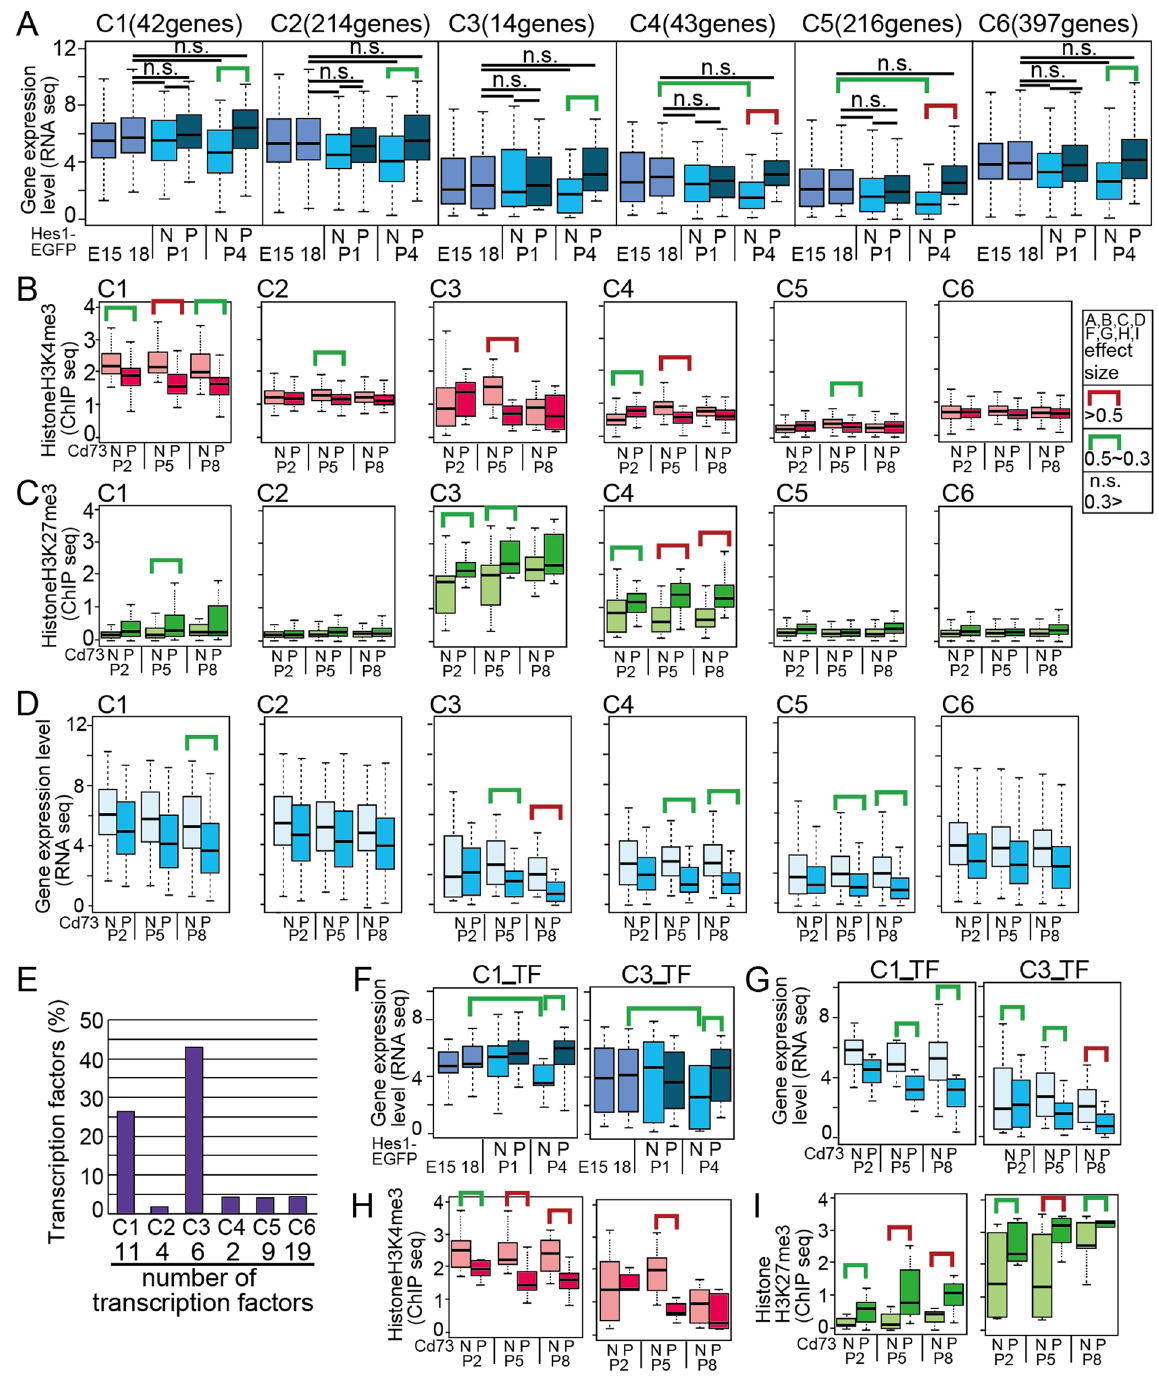
Figure 6. Characterization of genes upregulated in P4 but not in P1 in pHes- EGFP positive cell populations. Genes of pHes1-EPG at P4 but not included in pHes1-EPG at P1 were sub-clustered to C1 to C7 by using their values of H3K4me3 and H3K27me3 ChIP-seq of Cd73_P and Cd73_N fractions 13 , and distribution of gene expression levels (RNA-seq) in each cluster are shown by box plot ( A ). ( B – D ) Box plots of distribution of H3K4me3 (ChIP-seq, B ), H3K27me3 (ChIP-seq, C ), and transcripts level (RNA-seq, D ) of genes in each sub- cluster are shown. ChIP-seqs and RNA-seq were performed by using Cd73_P and Cd73_N retinal sub-fractions at P2, P5, and P8 13 . ( E ) Percentage of genes categorized to transcription factors by IPA in total number of genes in the clusters is shown. ( F – I ) Distribution of gene expression levels in pHes1-EPC or pHes1-ENC ( F ), or in Cd73_P and Cd73_N ( G ). Levels of H3K4me3 ( H ) and H3K27me3 ( I ) of Cd73_P and Cd73_N fractions of the transcription factors in each cluster are